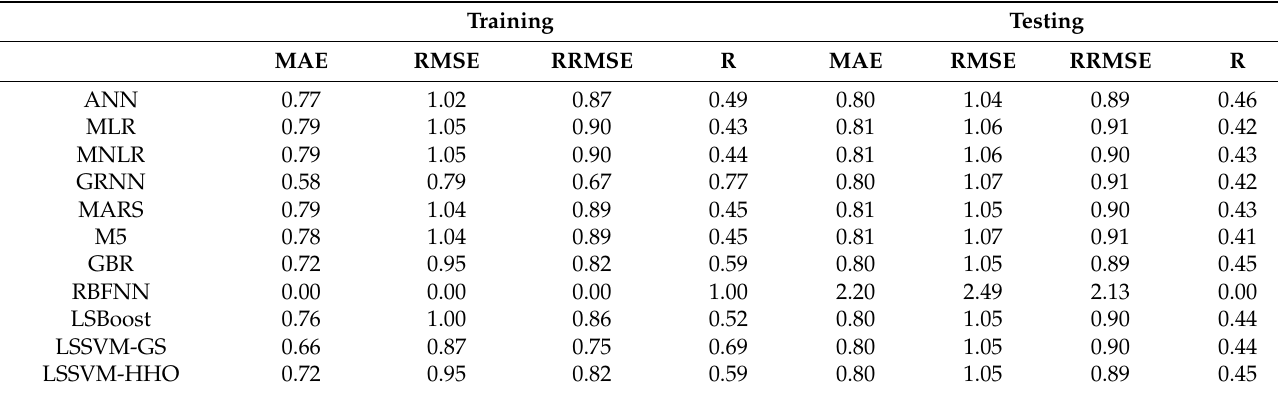
Table A4. Results of modeling WS with the base algorithms at the Mashhad